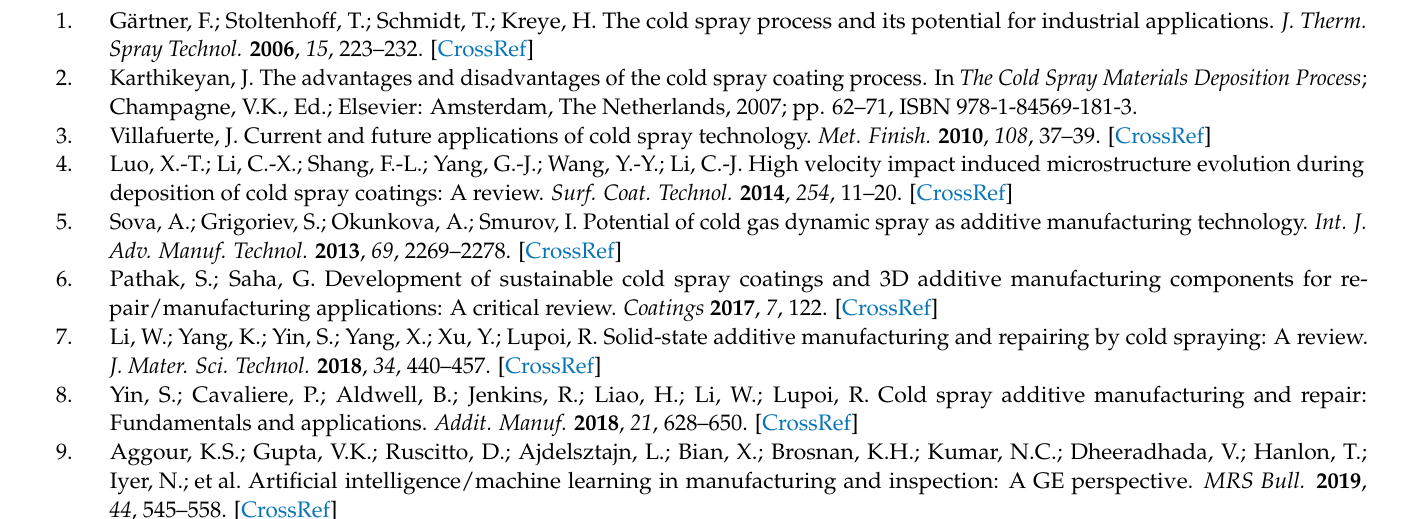
Table S1: Process parameters for the single-track profiles S1–S36 in the training dataset, Table S2: Process parameters for the single-track profiles S37–S48 in the testing dataset, Table S3: Curve-fitted coefficients of mathematical Gaussian function model for the single-track profiles S1–S36, Table S4: Curve-fitted coefficients of mathematical Gaussian function model for the single-track profiles